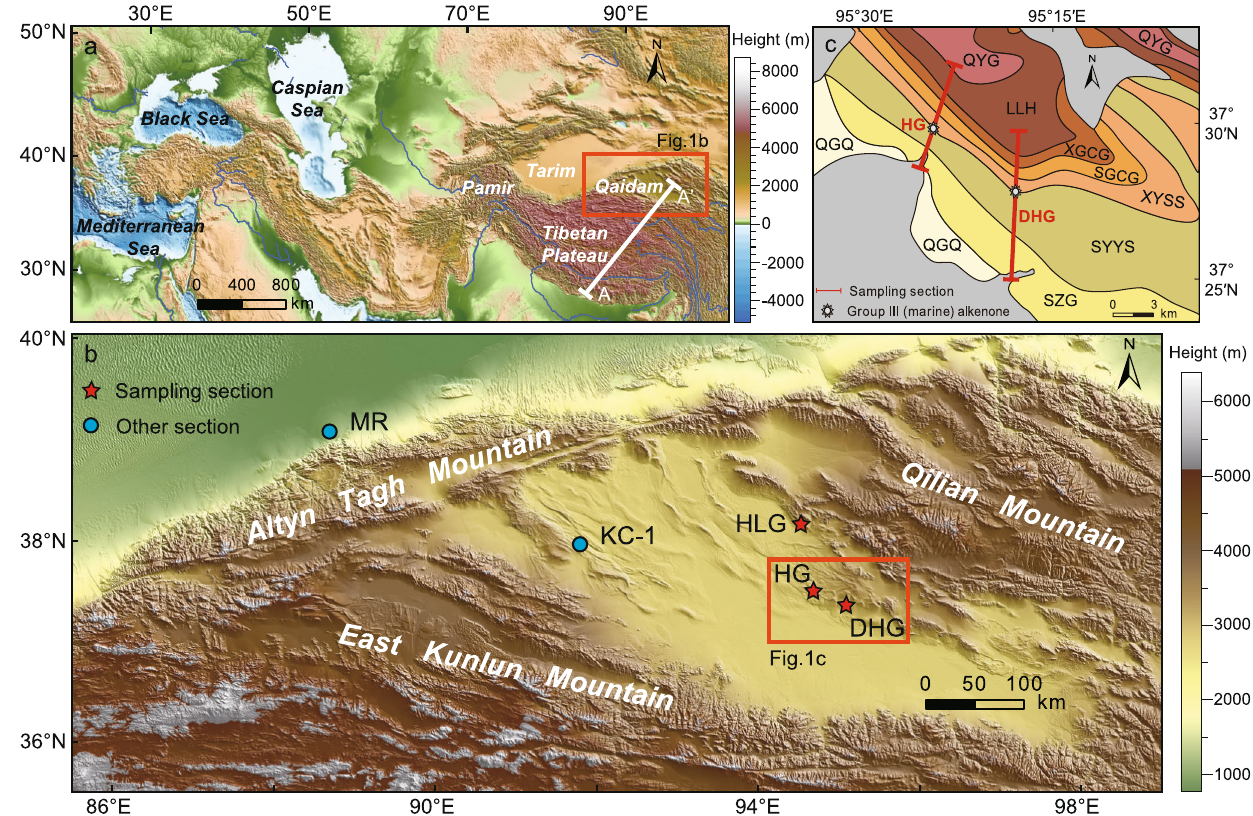
Fig. 1 Generalized topographic maps of the study region. a Digital elevation model of the Tibetan Plateau and remnants of the Paratethyan Sea located to the west of Pamir. Modern plateau topography along the transect AA ′ shown in Fig. 5. b Localities of the studied Dahonggou, Honggou and Hongliugou sections. Previously studied KC-1 well and Miran River section 17,27 are also indicated. Sections: DHG Dahonggou, HG Honggou, HLG Hongliugou, MR Miran River. c Geological map of the Dahonggou anticline showing locations of the discovered marine alkenones at the DHG and HG sections. Stratigraphic units: QYG Quanyagou, LLH Lulehe, XGCG Xia Ganchaigou, SGCG Shang Ganchaigou, XYSS Xia Youshashan, SYSS Shang Youshashan, SZG Shizigou, QGQ Qigequan